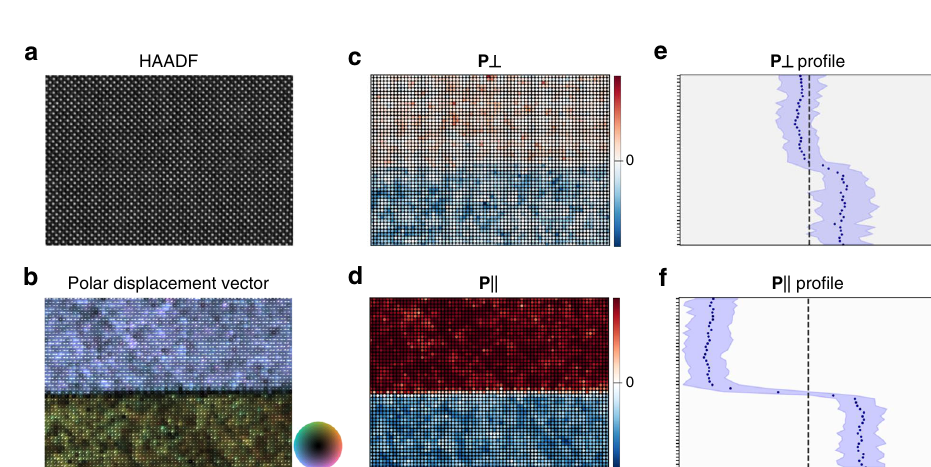
Fig. 4 Experimental data for 180° domain wall. a HAADF-STEM subregion of 180° BiFeO 3 domain wall. b Cation displacement vector map. c Color-scaled lattice positions of the P component perpendicular ( ½ (cid:1) 101 (cid:2) pc axis) and ( d ) parallel ([101] pc axis) to the domain wall. e Pro fi les of the mean values (datapoints) and 90% data bounds (blue) for perpendicular and ( f ) parallel P components.